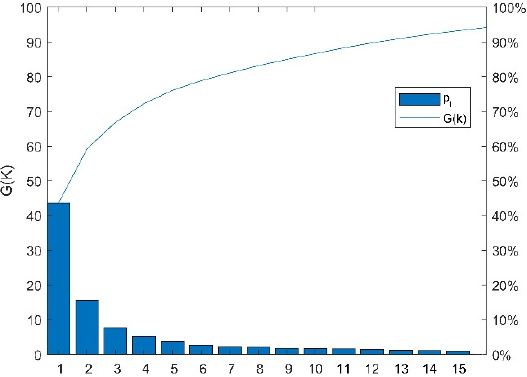
Figure 8. Cumulative contribution results of PCA principal components.